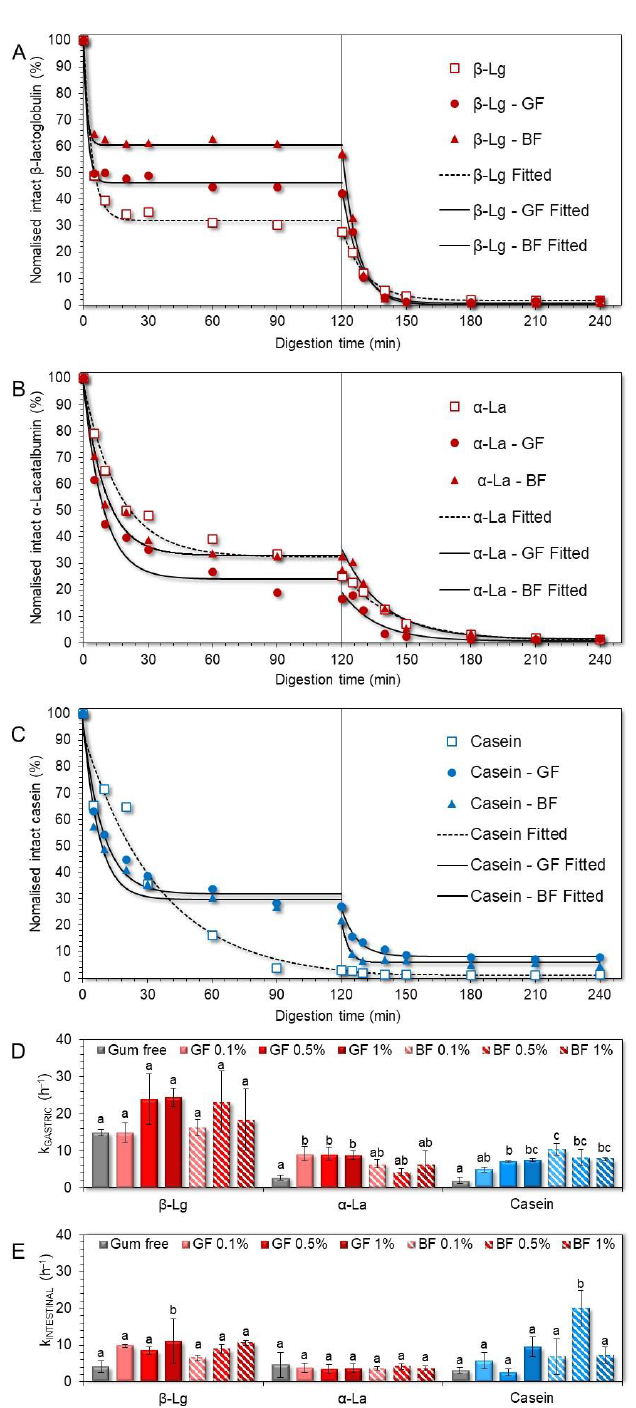
Figure 8. SDS-PAGE densitometric analysis illustrating the kinetics of β -lactoglobulin ( A ), α -lactalbumin ( B ), and total caseins ( C ) fate in the gastric (t = 0 − 120 min) and intestinal (t = 120 − 240 min) phases as influenced by the phenotype and concentration of flaxseed gum. The calculated rates for β - Lg, α -La and casein are depicted in ( D ) (gastric rates) and ( E ) (intestinal rates). a – c Different letters for the same protein type denote a significant difference among the samples. Abbreviations used: β - Lg: β - lactoglobulin, α - La: α -lactalbumin. By monitoring the temporal changes in the intact protein residue in the intestinal phases, an almost complete cleavage of the milk proteins was detected as less than 2 – 3%, and 10% of intact whey proteins and total caseins remained at the end of the intestinal processing. Based on the calculated kinetic parameters (Figure 8E), no significant